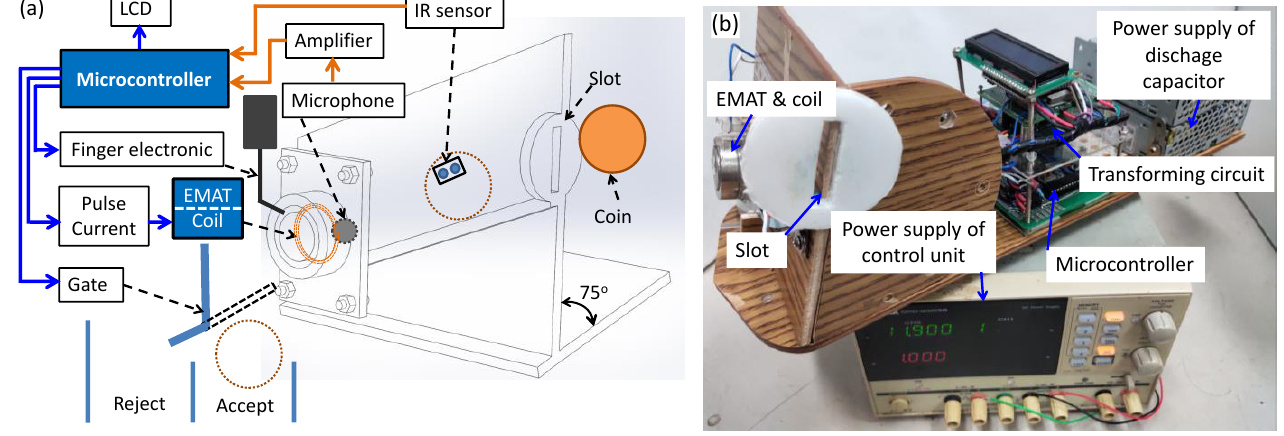
Figure 11. The microcontroller-based coin sorter with EMAT for classification of counterfeit and real coins: ( a ) functional diagram; ( b ) photograph of prototype.